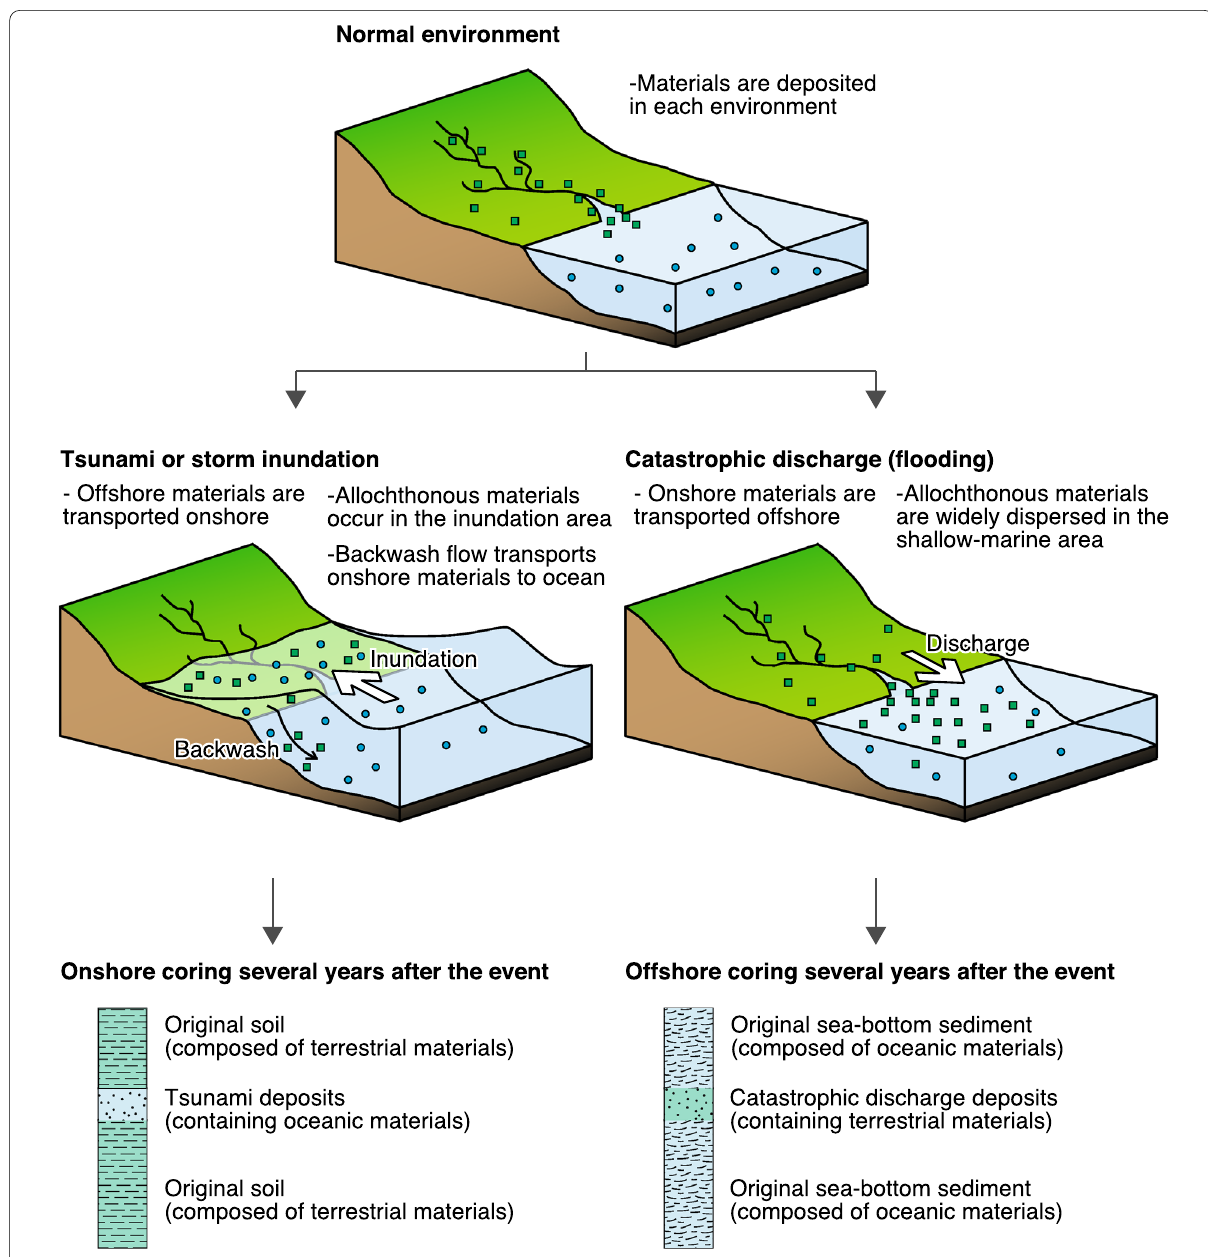
Fig. 1 Schematic diagram showing transportation of allochthonous materials. Green squares and blue circles indicate terrestrial and oceanic materials, respectively. Catastrophic events (e.g., tsunamis, storms, and flooding) cause transport of allochthonous materials; these materials become incorporated into the sedimentary record as event